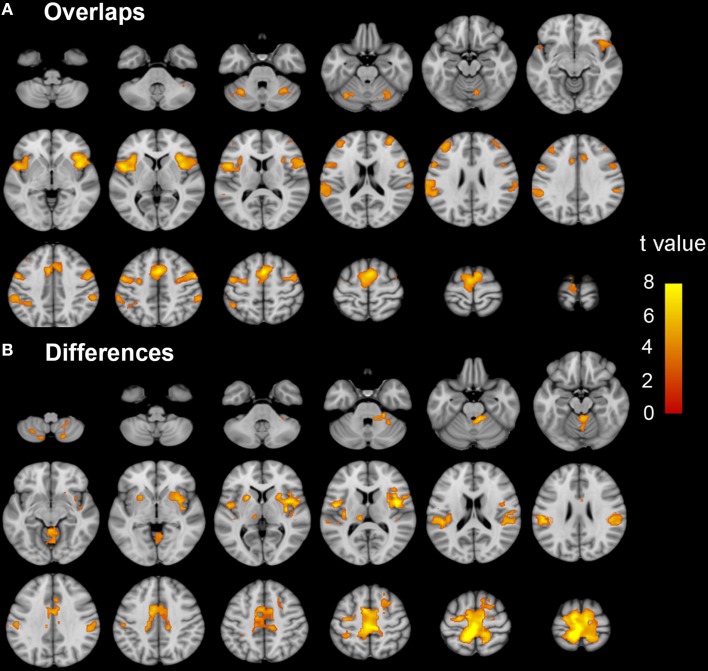
The coactivation and differences between the MI and ME tasks in the NC group. Conjunction analyses between the MI and ME tasks shows coactivation in the bilateral SMA, dorsal premotor cortex, ventral premotor cortex, IPL, CB vermal 6, lobules 6, and Crus 1, aINS, dlPFC, and SMG (A). Compared to the ME task, the MI task evoked weaker activation in the bilateral paracentral lobule, SMA, Putamen, SMG, CB lobule 8, right aINS, CB vermal and lobules 4–6, SFG and left thalamus (B). Significant activation was considered at a voxel-wise threshold of q < 0.01 (FDR correction) and a cluster ≥30 voxels. The right side of the image corresponds to the right hemisphere. The color bar represents the t-values. MI, motor imagery; ME, motor execution; NC, normal controls; SMA, supplementary motor area; IPL, inferior parietal lobule; CB, cerebellum; aINS, anterior insula; dlPFC, dorsolateral prefrontal cortex; SMG, supra marginal gyrus.